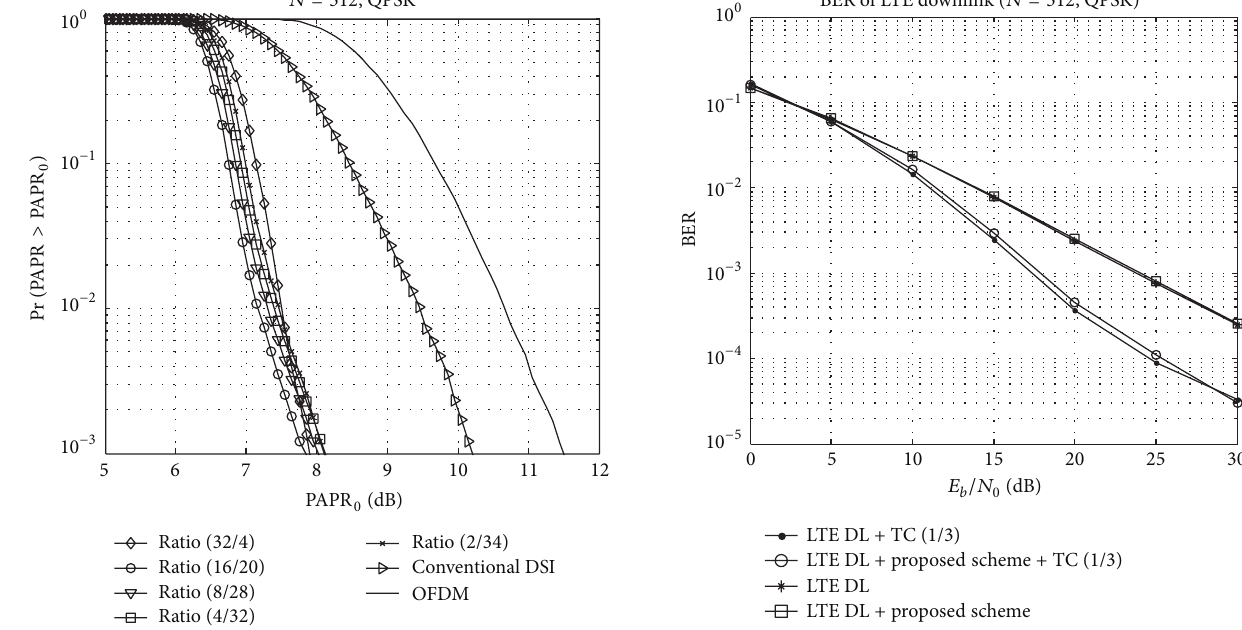
Figure 7: BER performance of the proposed scheme and LTE